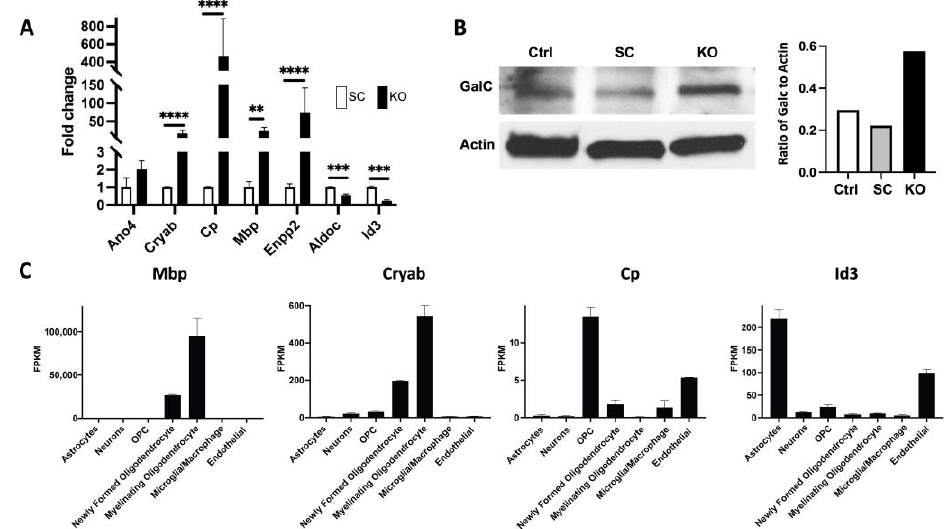
Figure 4. TCF12 loss causes upregulation of oligodendrocyte-specific genes in GL261 cells. ( A ) qPCR validation data showing upregulation of genes enriched in oligodendrocytic lineages: Ano4, Cp, Cryab, Mbp, and Enpp2; and downregulation of genes enriched in astrocytes: Aldoc and Id3. ** p < 0.01, *** p < 0.001, **** p < 0.0001. ( B ) Western blot analysis and quantification showing upregulation of GalC, a marker for mature oligodendrocytes, in TCF12 KO GL261 cells compared to control and scramble cells. The uncropped blots are shown in Figure S4. ( C ) RNA-Seq data from the Brain RNA-seq database (brainrnaseq.org) showing expression profiles in different lineages of the genes Mbp, Cryab, Cp, and Id3.